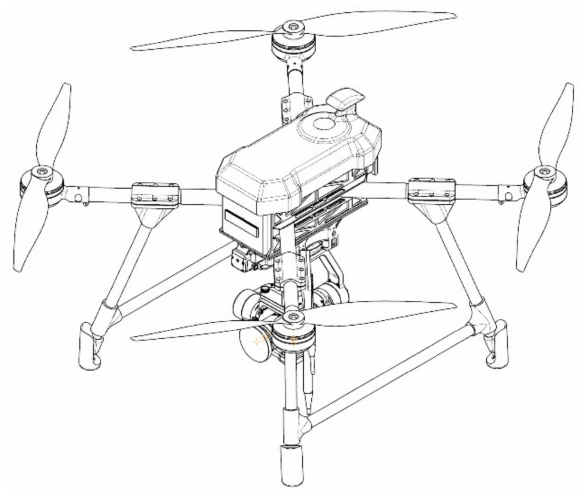
Figure 1. The quadrotor used in the experiments (CAD